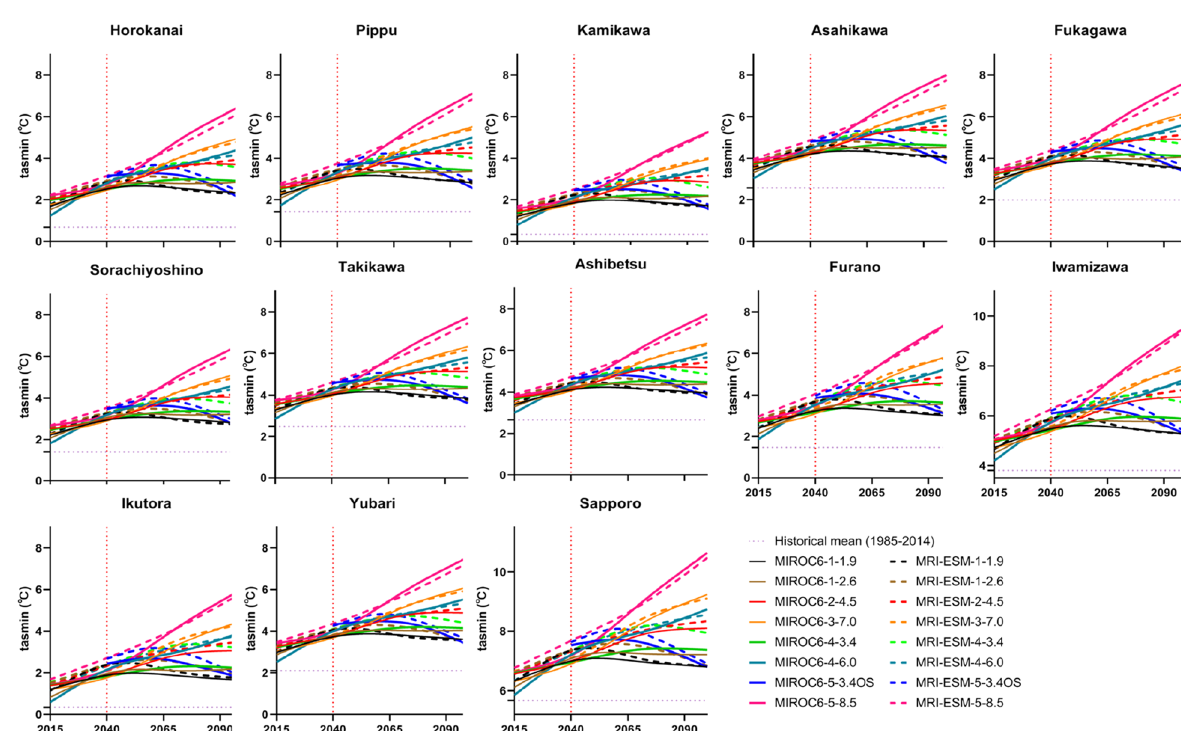
Figure 6. Annual mean minimum temperature (tasmin) under SSP-RCPs scenarios of two